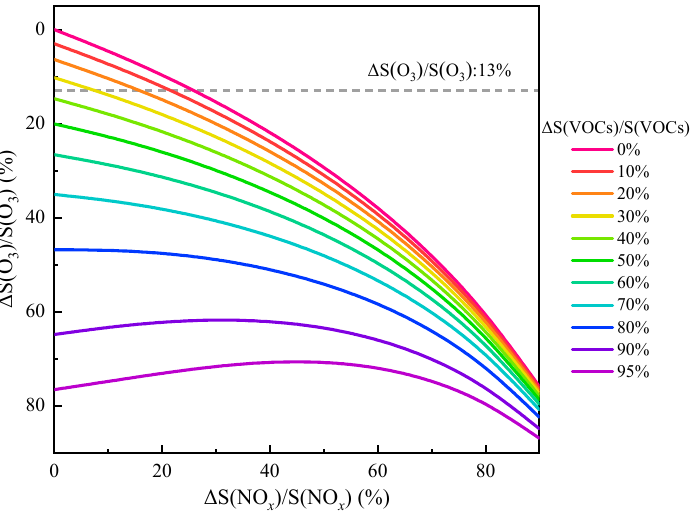
Figure 8. Modeled response of O 3 concentrations to the mitigation of S(NO x ) and S(VOCs) based on the O 3 polluted scenario, where S(VOCs), S(NO x ), and S(O 3 ) represent the concentrations of VOCs, NO x , and O 3 , respectively.